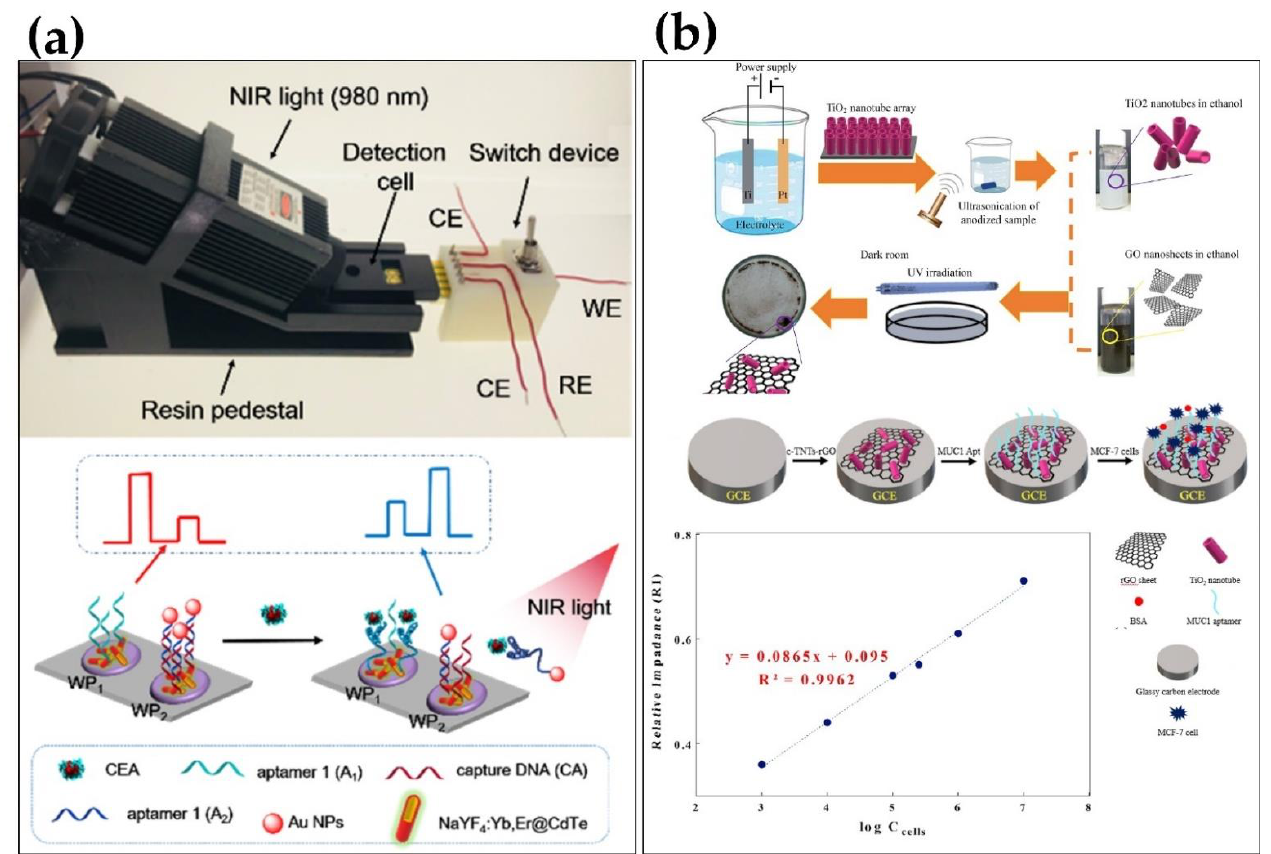
Figure 5. Schematic presentation of electrochemical aptasensor for the detection of breast cancer. ( a ) A ratiometric photoelectrochemical aptasesnor for the detection of CEA. ( b ) A graphene oxide-based aptasensor for the detection of MUC1. Reprinted with permission from Refs. [62,106].